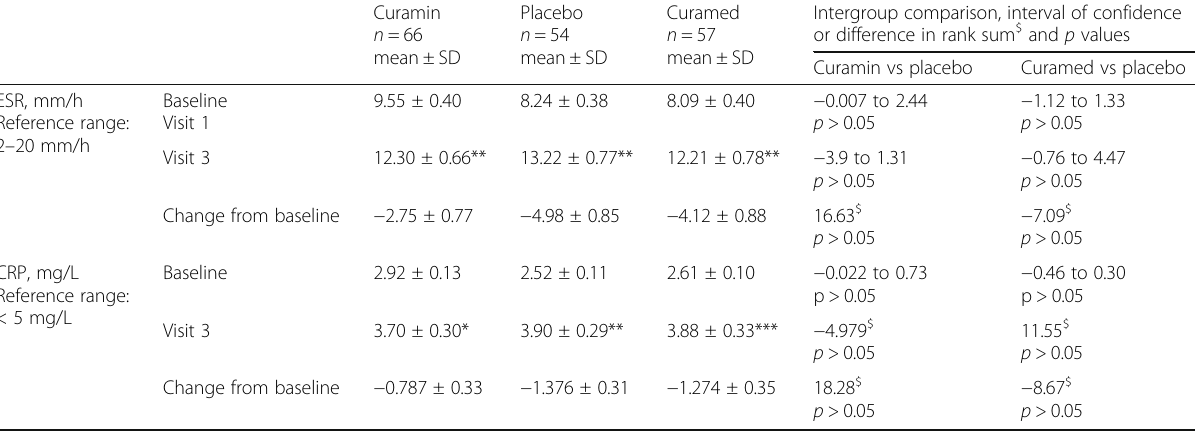
Table 6 Within (columns) and inter-groups (lines) comparisons of erythrocytes sedimentation rate (ESR) C-reactive protein (CRP) in blood of patients completed all testes